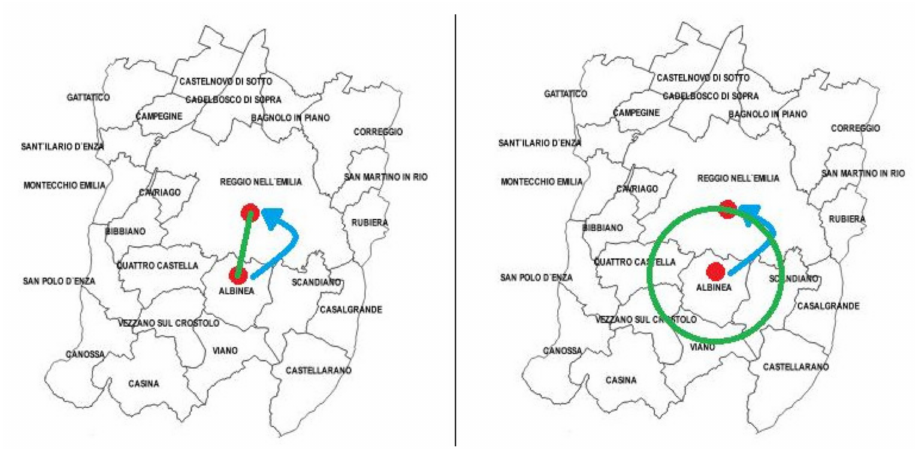
Figure 5. Image representing the difference between the gravity model and the radial one. In this example, we consider the municipality of Albinea (departure) and the municipality of Reggio nell’Emilia